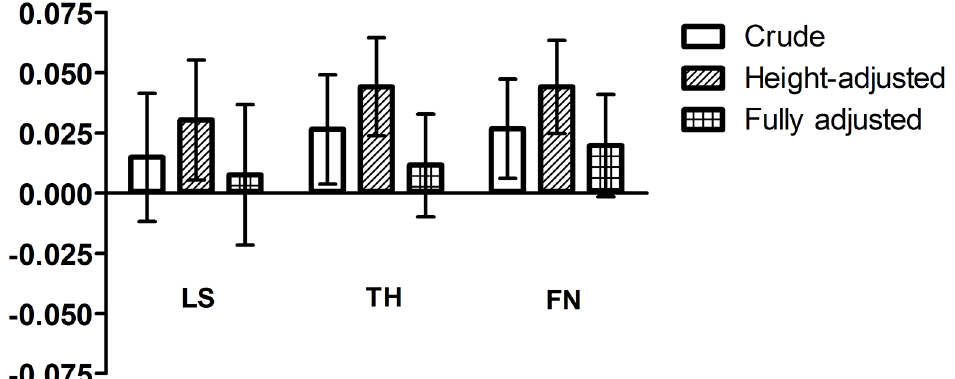
Fig 1. Difference between RUM and RNM in bone mineral density at lumbar spine (LS), total hip (TH), femoral neck (FN). Bars represent mean values with 95% CI for different models: crude, height, and fully